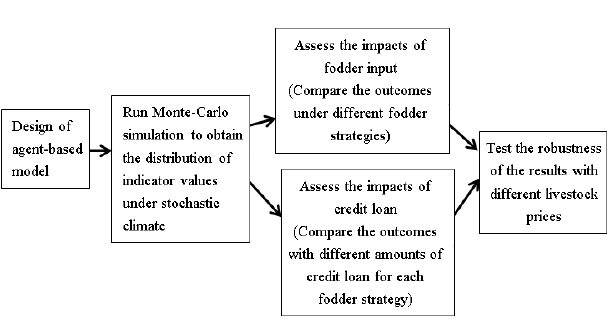
Fig. 1 . The framework of the